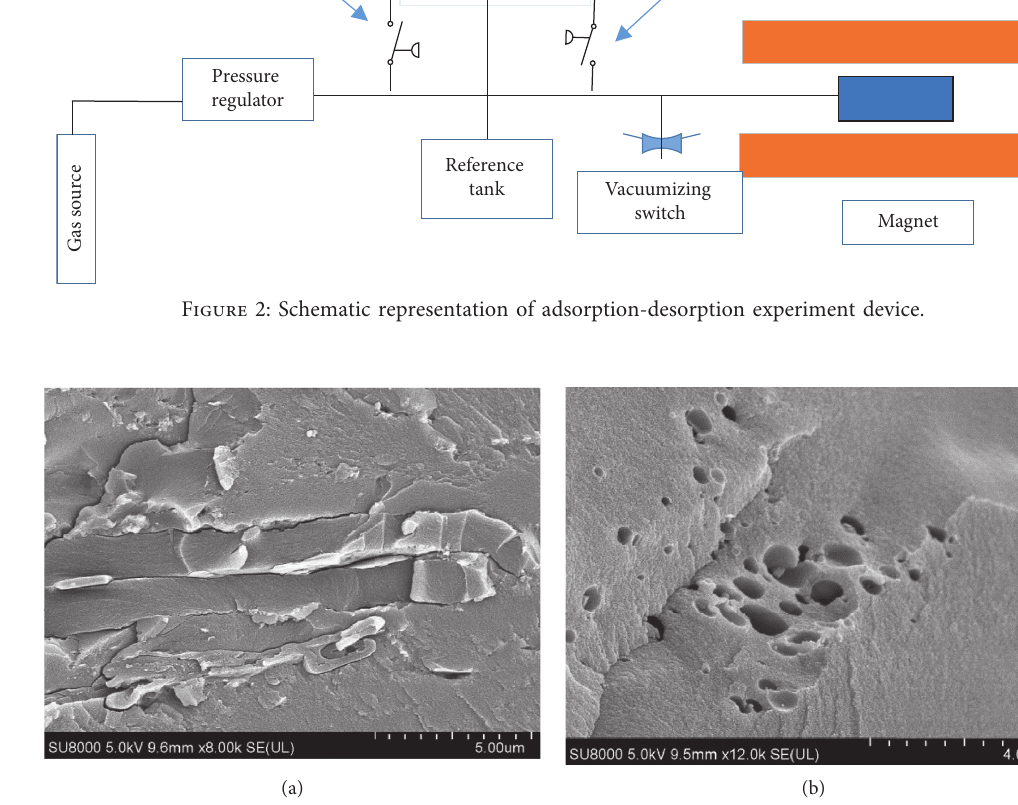
Figure 3: Scanning electron microscopic image of coal samples: (a) abundant microcracks (8000 of magnification time) and (b) abundant “pyrolysis pores” (12000 of magnification